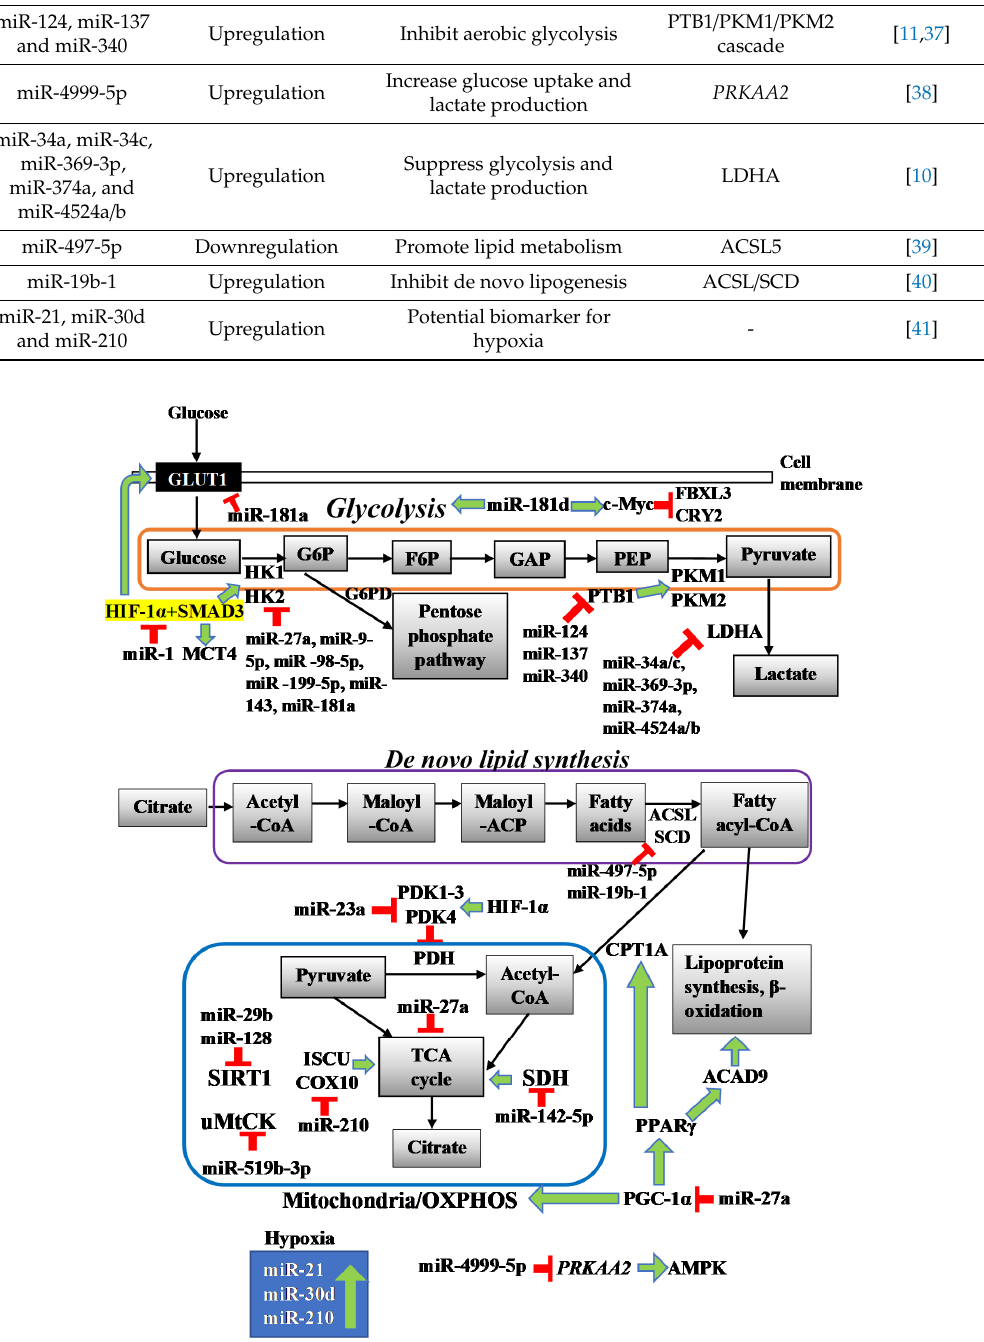
Figure 1. MicroRNAs modulate colorectal cancer (CRC) cell metabolism by targeting key metabolic enzymes and signalling pathways. Red sign indicates inhibition while green arrow indicates upregulation / promotion. G6P: glucose 6-phosphate, F6P: fructose 6-phosphate, GAP: glyceraldehyde 3-phosphate, PEP: phosphoenolpyruvate.